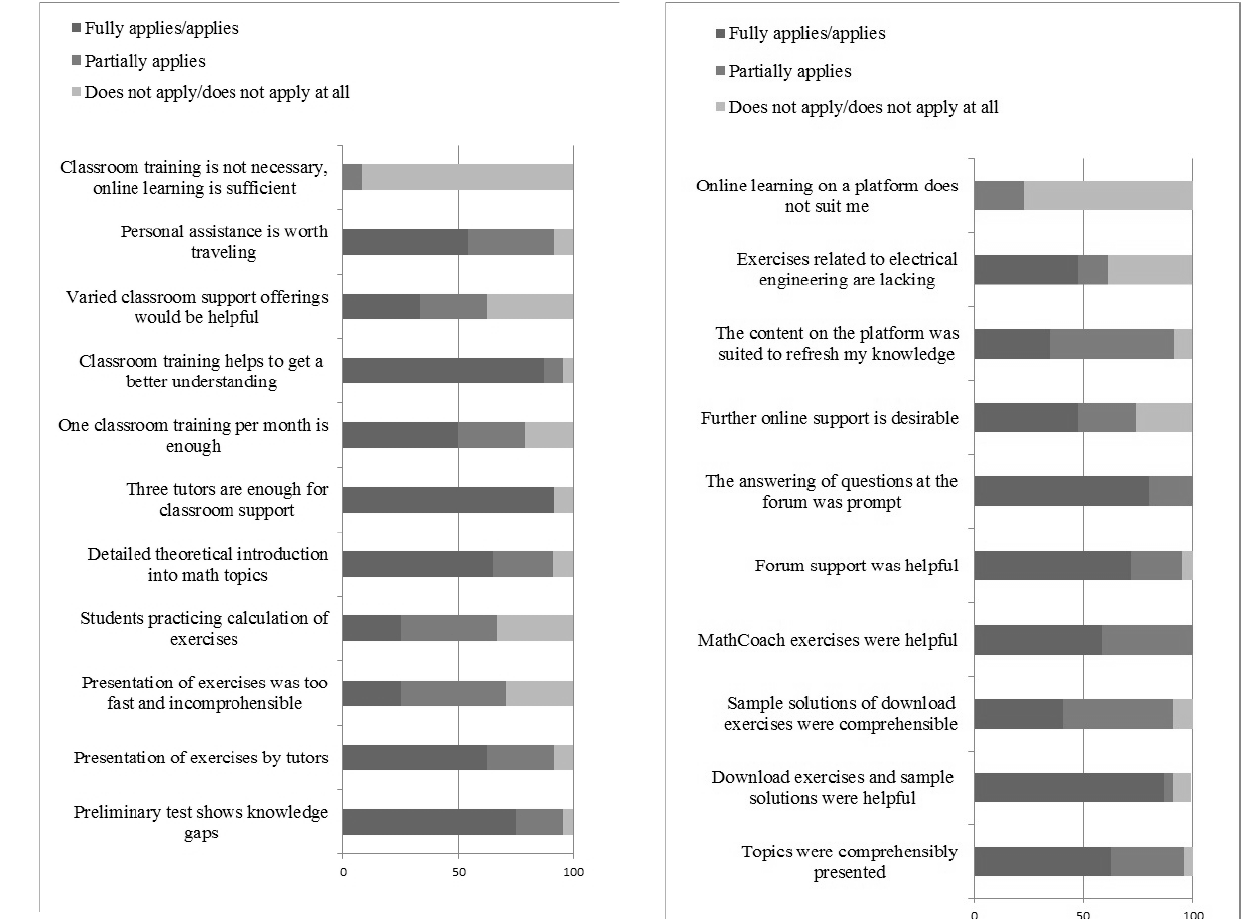
Figure 7. Category: classroom training at the university